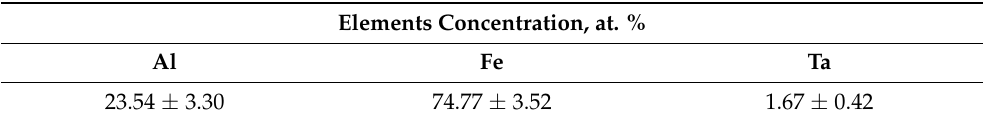
Table 1. The average concentration of the constituting elements measured by EDX on several powder particles.